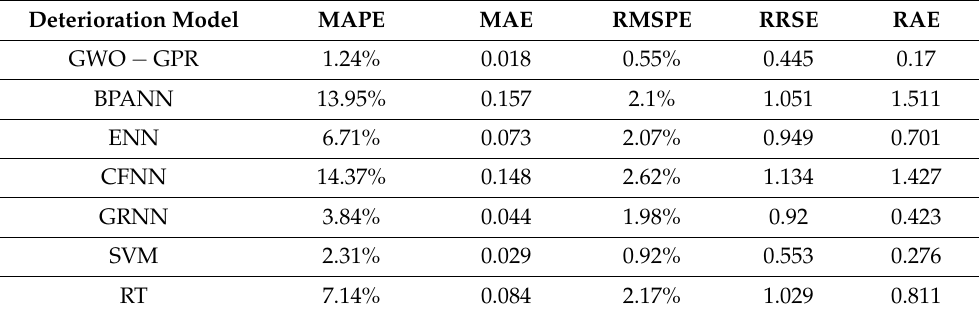
Table 4. Performance comparison between deterioration prediction models of concrete interior walls.